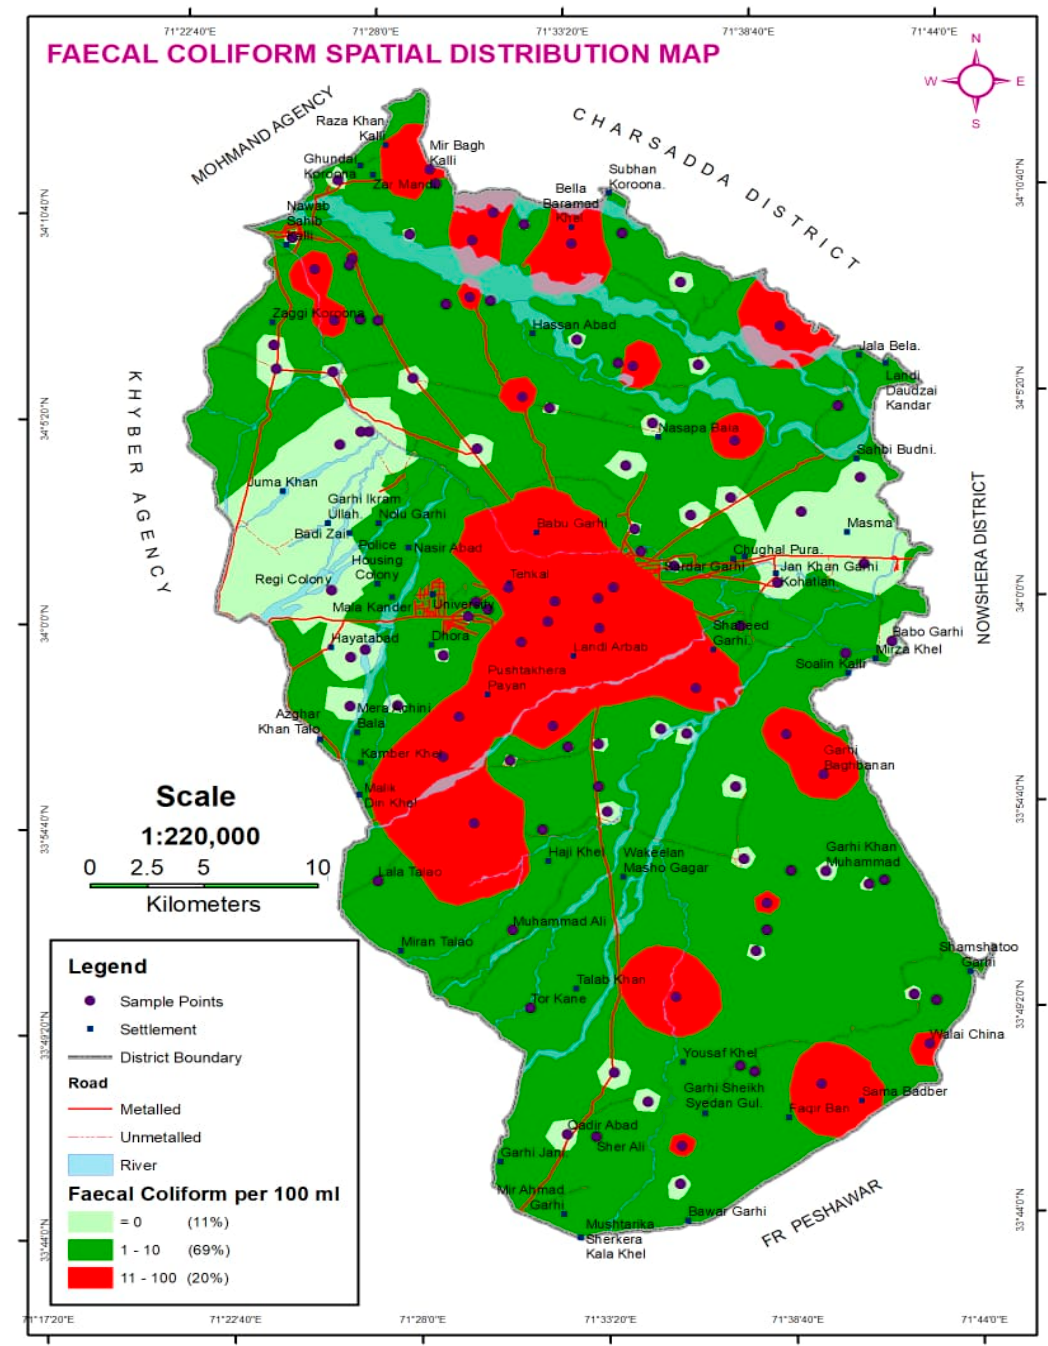
Figure 4. Faecal coliforms spatial distribution map of Peshawar .